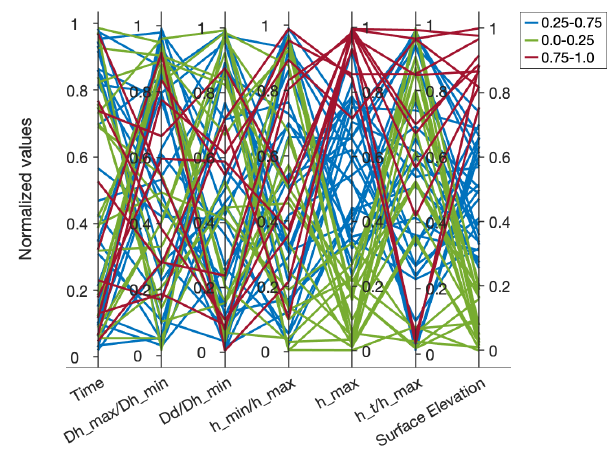
Figure 5. The parallel coordinates plot shows the choice of input parameters and the output maximum surface elevation at the design location for the 60 experiments. All the data values are